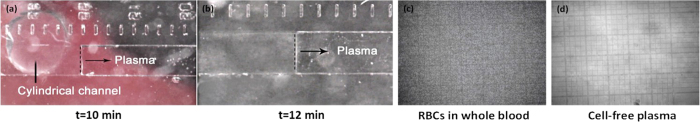
(a–b) Optical images showing the flow of separated plasma in the top channel at two different locations x = 1.0 mm and 10 mm at time t = 10 min and 12 min, respectively (c–d) whole blood and plasma on the haemocytometer grid.